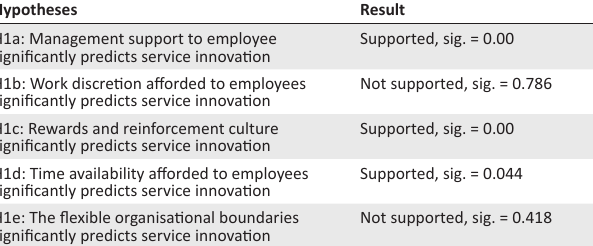
TABLE 8: Results of hypotheses testing.